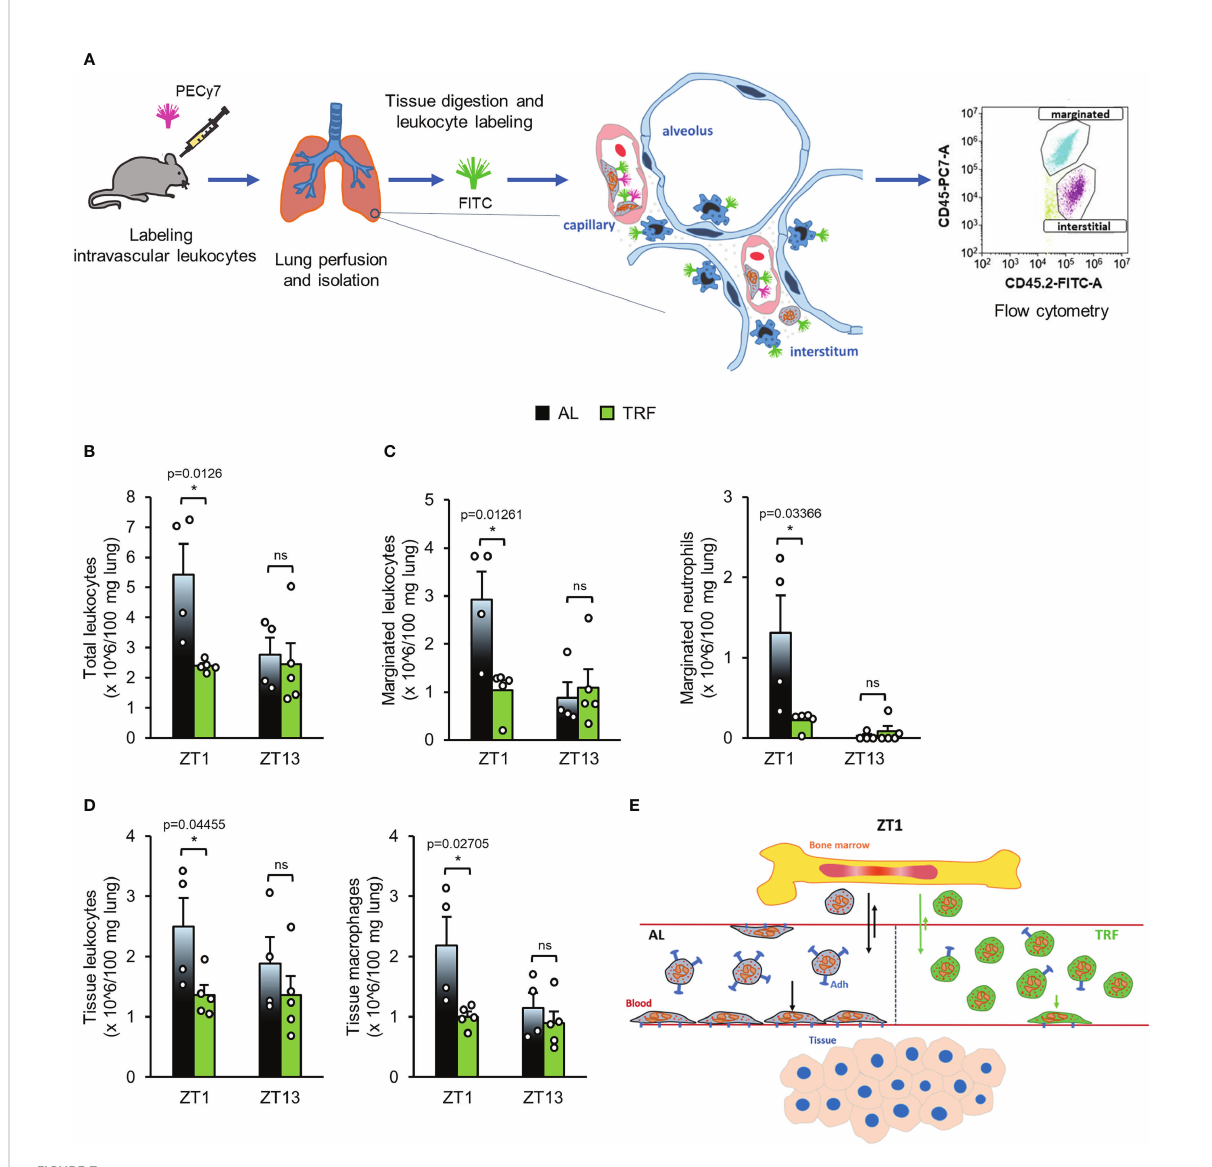
FIGURE 7 Time restricted feeding decreases the migration of leukocytes to the lung. (A) Experimental setup to the identi fi cation of leukocyte populations in the lungs. For further details see Materials and Methods. (B-D) Leukocyte populations in the lungs: total leukocyte (B) , marginated (adhered) leukocyte and neutrophil (C) , tissue leukocyte and macrophage (D) counts in the lungs at ZT1 and ZT13 (mean + SEM, n = 4 (AL) and n = 5 (TRF), two-sample t-test, * p < 0.05). (E) Time-of-the-day-dependent changes of neutrophil counts in blood. Abundance of circulating neutrophils is determined by rhythmic alterations of cell traf fi cking between blood and bone marrow and intensity of margination to the endothelial surface and migration from the intravascular space into the tissues. Arrows indicate the direction and intensity of leukocyte movements in the AL (black) and TRF (green) groups, respectively. The model suggests that the lower expression of adhesion molecules in the TRF group weakens the margination capacity resulting in signi fi cantly increased neutrophil count in blood during the inactive phase of mice. Adh, Adhesion molecule ns, not signi fi